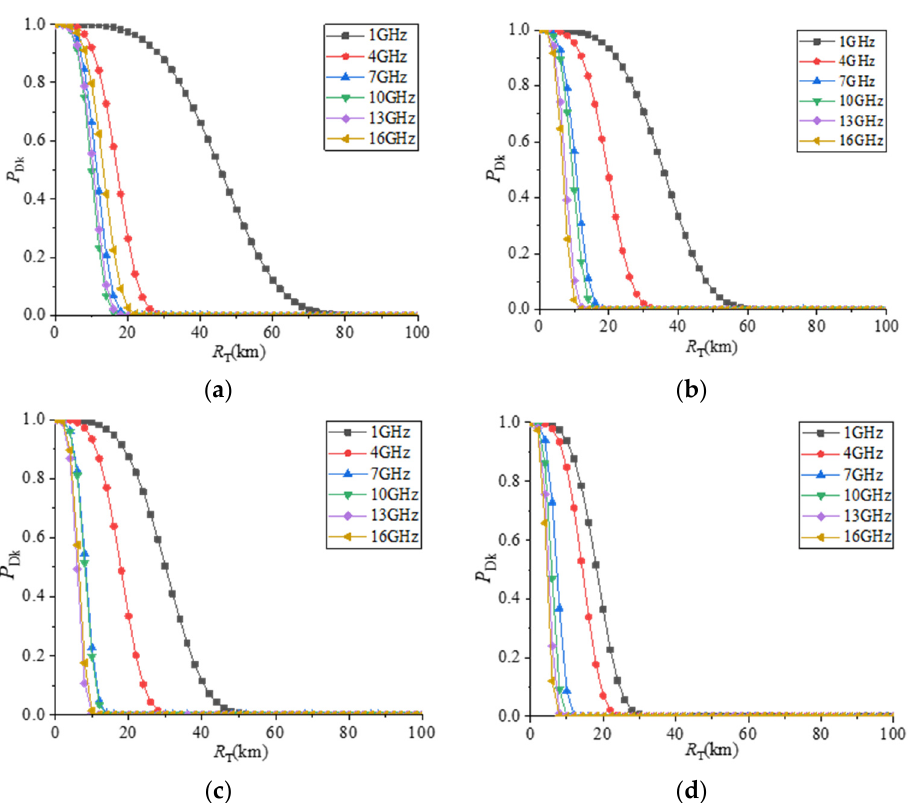
Figure 18. Comparison of the comprehensive detection probability of three kinds of stealth satellites by radars with different frequencies. ( a ) TX-1; ( b ) non-stealthy attitude of the Olive-A; ( c ) stealthy attitude of the Olive-A; ( d ) Olive-B. Table 5. Comparison of the radar maximum detection distance of satellites with a 10% probability of detection of the